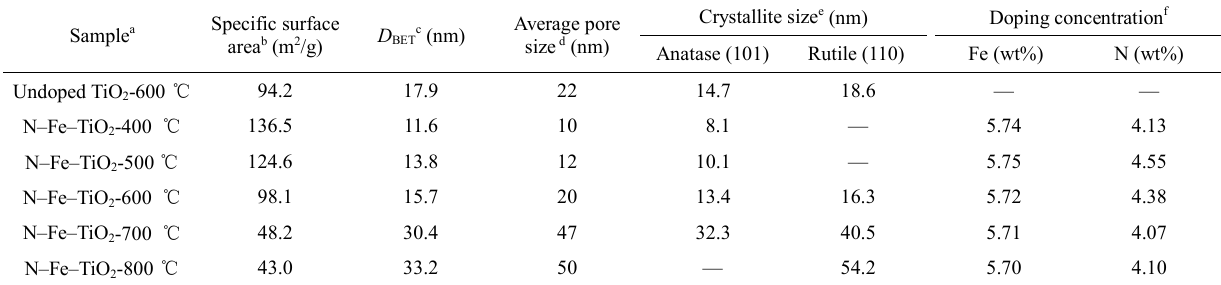
Table 1 Textural properties of N–Fe codoped TiO 2 nanorods fabricated via template-directed LPD process annealed at different